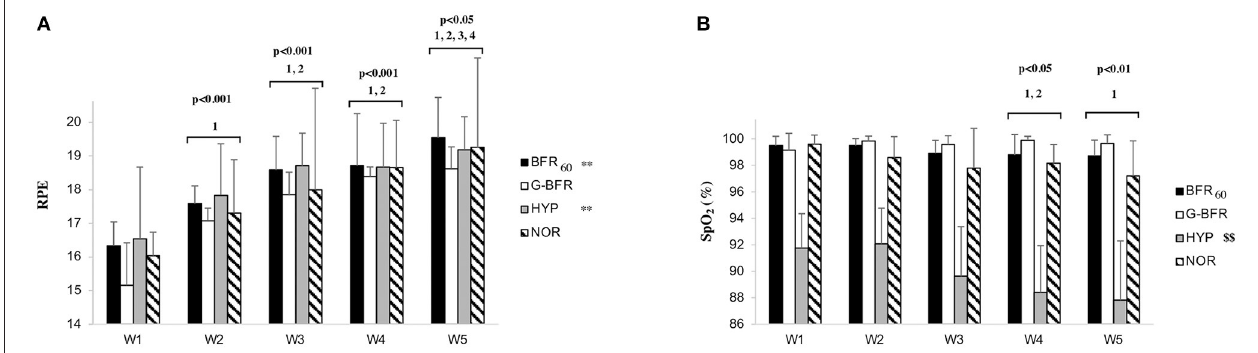
FIGURE 1 | Rating of perceived exertion (RPE) (A) and SpO 2 (B) values between the different conditions. BFR 60 , blood flow restriction during the two first minutes of recovery; HYP, hypoxia in a chamber at 13.0% FiO 2 ; G-BFR, gravity-induced BFR; NOR, control. Differences between the numbers of the sprint are highlighted by numbers and symbols are used for differences between conditions. 1 Different from sprint number one; 2 different from the second sprint; 3 different from the third sprint; 4 different from the fourth sprint, these differences concern the effect of sprint number without distinguishing the exercise modality (n.b., no statistical interaction was found); ** p < 0.01 different from G-BFR; $$ p < 0.01 different from the other conditions.